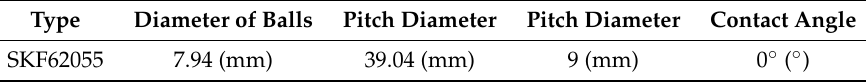
Figure 12. Experimental setup. Table 2. Structural parameters of rolling